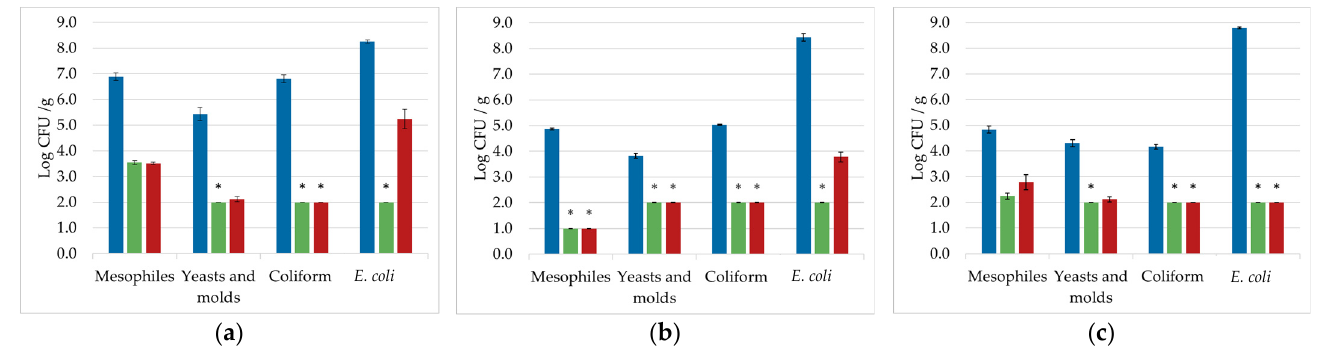
Figure 1. Microbial counts of total mesophiles, yeasts and molds, total coliforms, and spiked E. coli , measured on coriander ( a ), carrot ( b ), and coconut ( c ), in the untreated samples ( ), the ones treated directly with high-pressure carbon dioxide (HPCO 2 , ) and the ones treated inside the packaging (HPMAP-CO 2 , ). Treatment conditions were: 120 bar/40 °C/20 min for carrots, 100 bar/40 °C/1 min for coriander, and 120 bar/45 °C/30 min for coconut. *ND—Not detected. No colonies were found at the lowest dilution possible (<2.0 log CFU/g for yeasts and molds, coliforms, and E. coli , <1.0 log CFU/g for mesophiles).